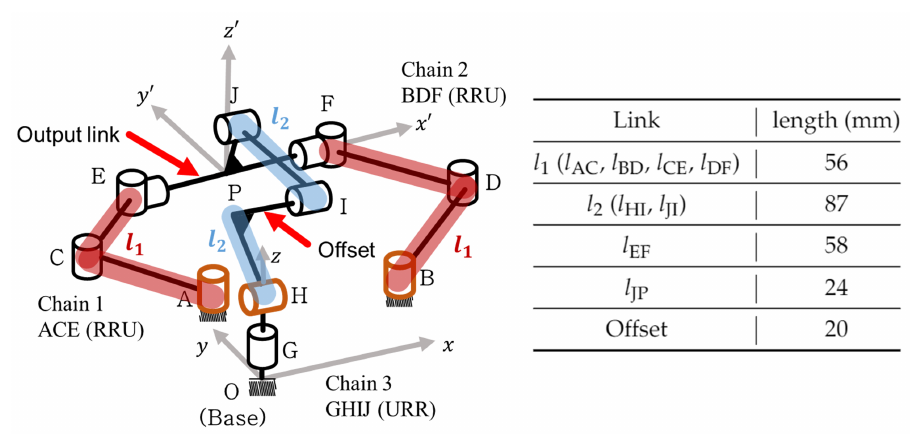
Figure 16. The design variables of each link for prototype.